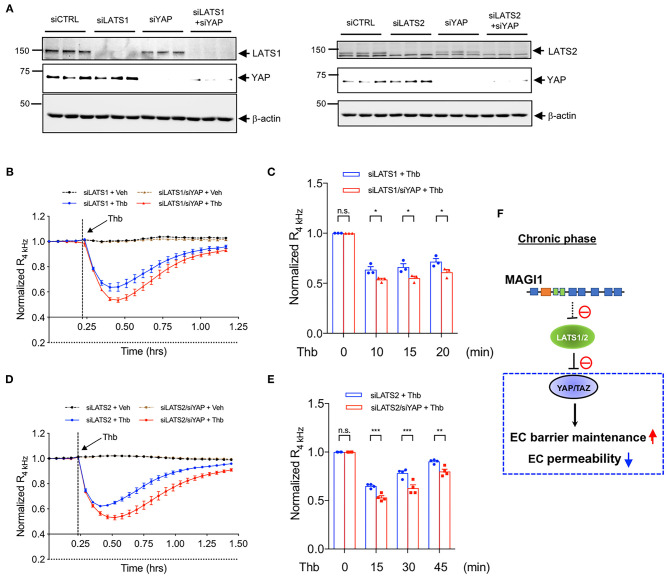
YAP is required in the maintenance of EC barrier function, especially in LATS1/2 depleted condition. (A) HAECs were transfected with (Left panel) either siLATS1 or siYAP, or the combination of siLATS1 and siYAP; (Right panel) either siLATS2 or siYAP, or the combination of siLATS2 and siYAP, and IB analyses of LATS1/2 and YAP protein expression levels in resulting cell lysates were performed using anti-LATS1 or 2, anti-YAP, anti-β-actin as indicated (B–E). Thb (2.5 U/mL)-mediated reduction in TEER values observed in cells transfected with siLATS1 (A left panel, blue in B,C), siLATS2 (A right panel, blue in D,E) was increased to a greater extent by siYAP transfection, as assessed by the ECIS system and shown as normalized resistance measured approximately every 4 min for indicated times. The dashed line indicates addition of Thb. A reduction in TEER values indicates an increase in cell barrier permeability (33) through paracellular mechanisms (34). (C,E) Graph demonstrates normalized resistance after Thb treatment at indicated times, relative to basal level (mean ± SEM, n = 3). Statistical significance was assessed using ANOVA followed by Bonferroni post-hoc testing for multiple group comparison. ***P < 0.001, **P < 0.01, and *P < 0.05. (F) Scheme of MAGI1-mediated Hippo pathway regulation.